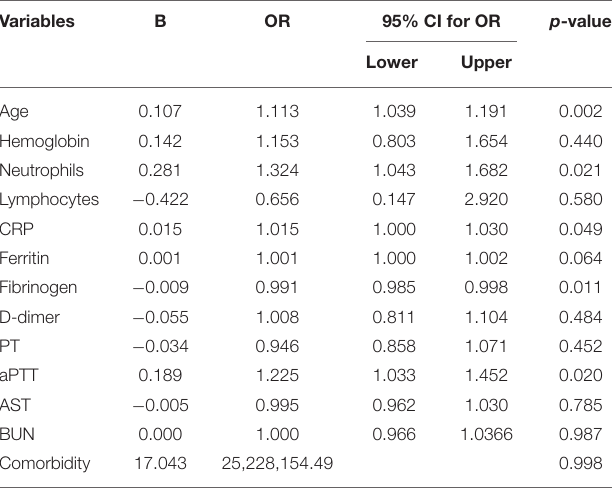
TABLE 6 | Age as predictor of mortality, adjusted for blood cell count, biological inflammatory markers, coagulation tests, AST, and BUN (logistic